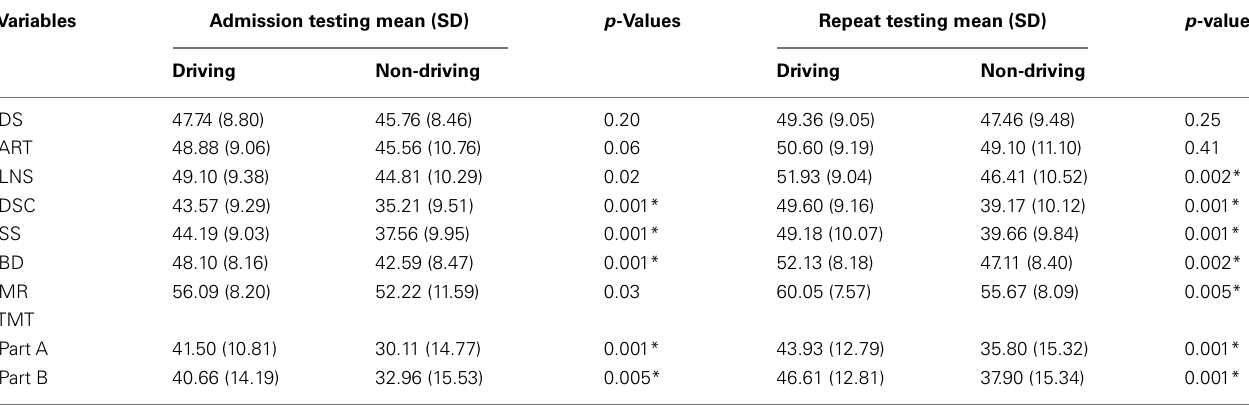
Table 5 | Independent samples t -test between driving and non-driving groups at admission and repeat